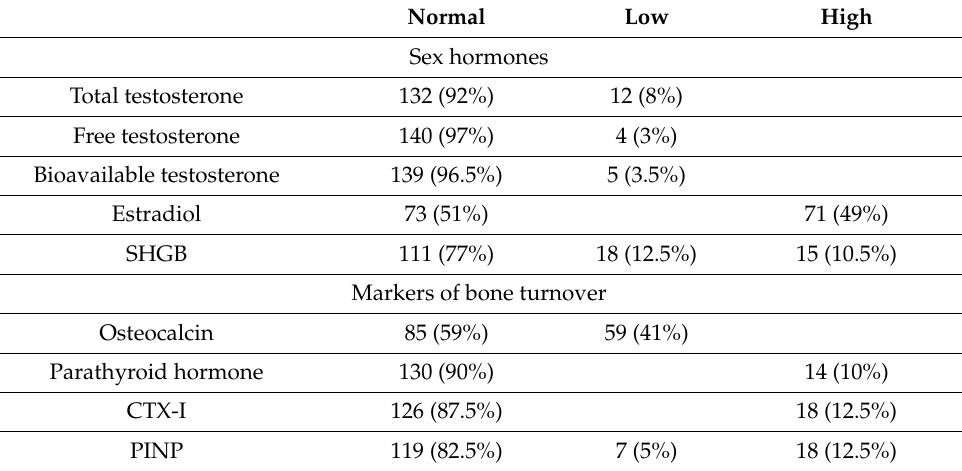
Table 2. Frequency of abnormal values of sex hormones and bone turnover markers.